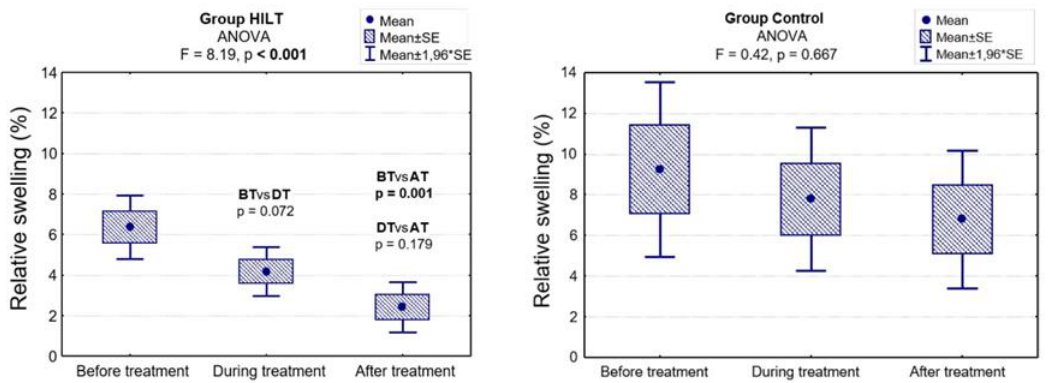
Figure 2. Relative swelling before, during and after treatment in group HILT and group C, and the